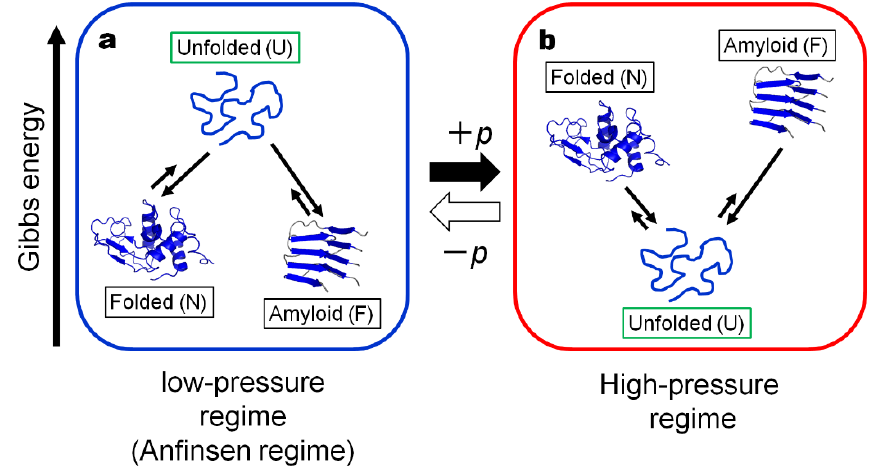
Figure 1. The schematic Gibbs energy diagrams for the proposed three generic forms of a protein; Folded (N), Unfolded (U) and Amyloid fibril (F): ( a ) in the “Anfinsen regime” or the low-pressure regime and ( b ) in the high-pressure regime. The “Anfinsen regime” is the regime realized in nature, while the high-pressure regime is the regime artificially realized in high-pressure vessels. Note that the thermodynamic stabilities of N, U and F are reversed in the two regimes, because of the large p Δ V contribution. Here the relative Gibbs energy levels for U, N and F are drawn arbitrarily.